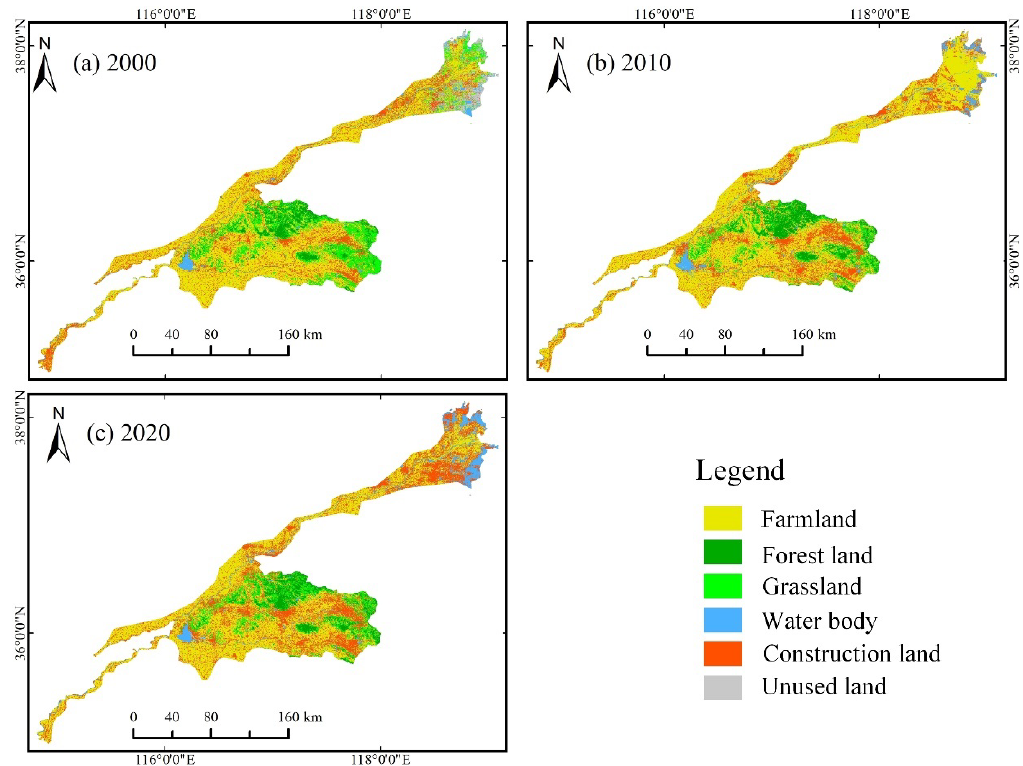
Figure 4. Three typical image subsets ( A – C ) with their classification results.